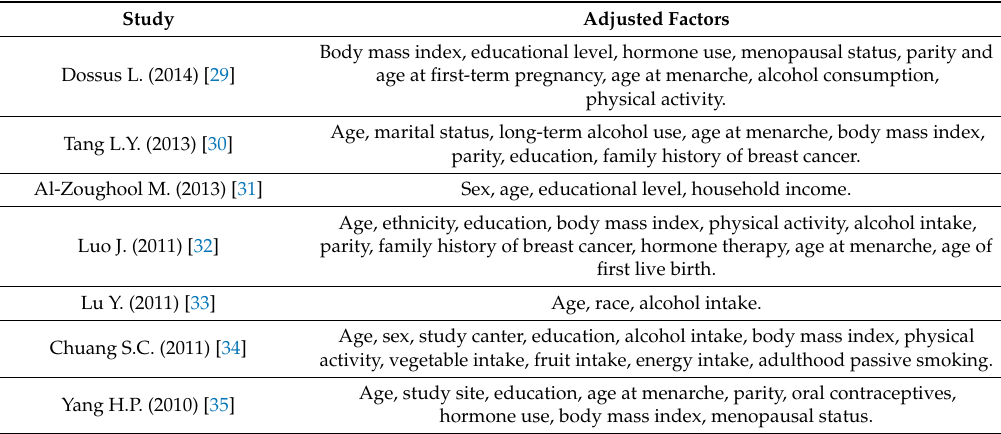
Table A1. Adjusted covariates of each